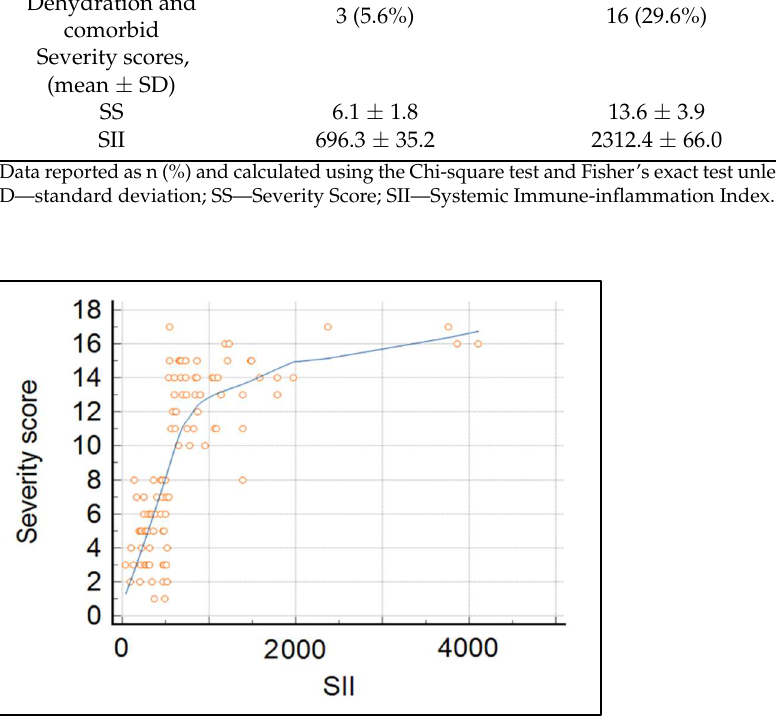
Figure 1. Scatter diagram of Symptom Severity Score and Systemic Immune-inflammation Index. The hazard ratios (HR) and adjusted odds ratio (aOR) for SII and SS scores were calculated using admission parameters for predicting SIRS and sepsis after odontogenic infections. The adjusted odds ratio for the SII score regarding SIRS development in patients admitted with OI was 2.09 (95% CI = 1.16–5.17), while the SS score had a lower OR value for determining SIRS development, with an insignificant confidence interval (OR = 1.75, 95% CI = 0.98–2.83). When the risk was calculated for sepsis as the dependent variable, both SII and SS scores had a significant value after adjustment for age, comorbidities, and gender, as described in Table 5. The area under the curve (AUC) identified both the SII and SS scores as accurate predictors for the development of sepsis and SIRS using admission features of OI patients. As seen in Figure 2, the AUC for the SII score in predicting sepsis was 75.6%, compared to the AUC for the SS score of 78.0%. Lastly, the AUC for the SII